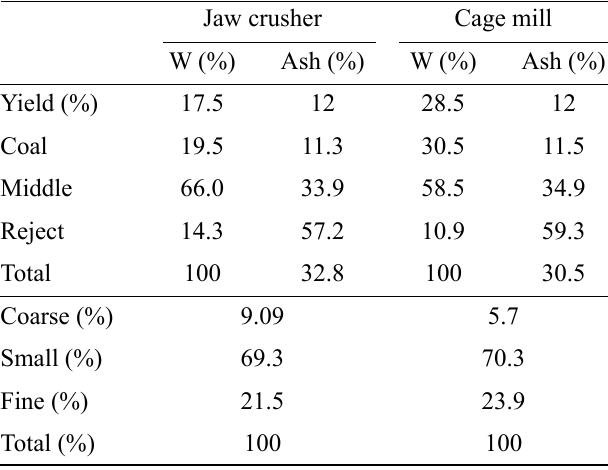
Fig. 6. Schematic diagram of the sink-float experiment [13]. Table 3. Washability test middle samples results and the amount of concentrates, middle and waste in the middle materials (after crushing).